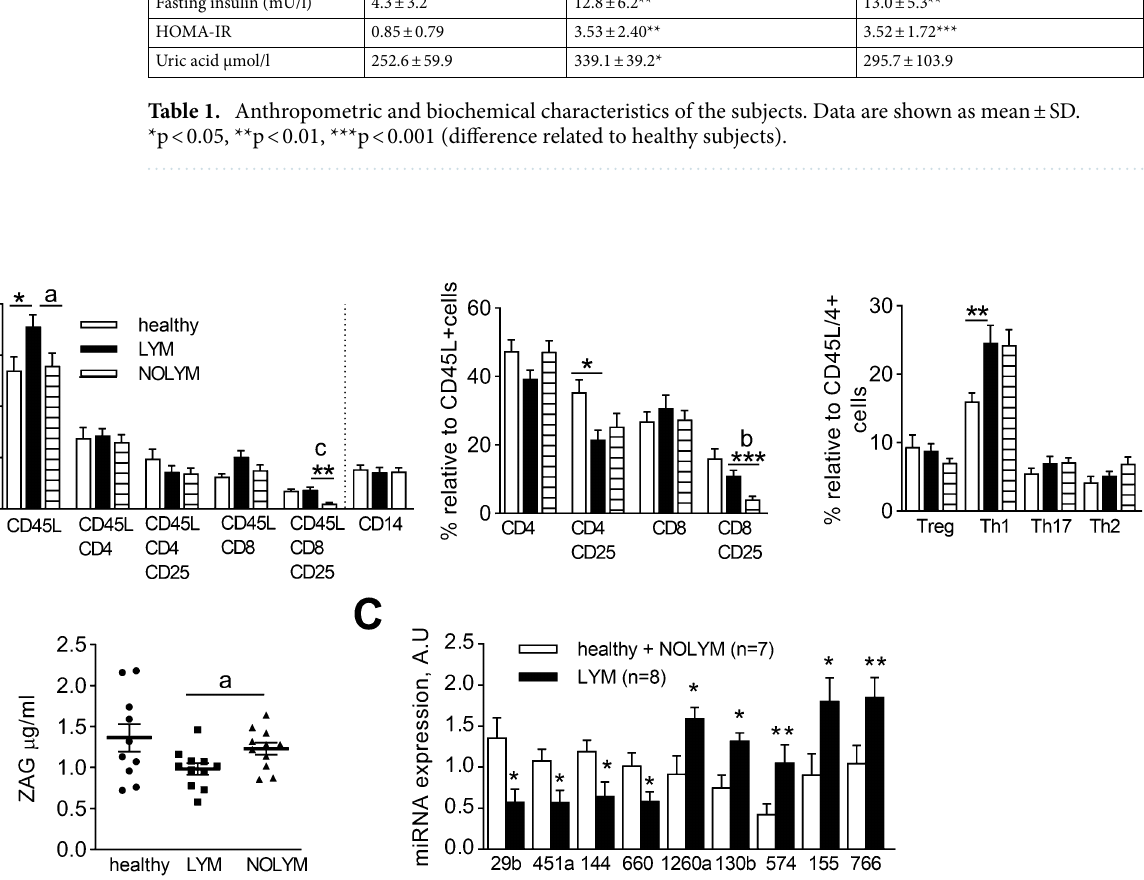
Figure 1. Systemic effects of lymphedema. ( A ) Relative content of immune cell populations in peripheral blood, expressed as percentage of CD45+ positive cells, CD45+ positive cells within lymphogate or CD45/ CD4+ positive cells within lymphogate (ANOVA of LN transformed data, Bonferroni correction for post-hoc analysis, comparison to LYM group, *p < 0.05, **p < 0.01, Mann Whitney test comparison LYM vs. NOLYM, a- p < 0.05, b- p < 0.01, c- p < 0.001). ( B ) Concentration of ZAG in plasma (Mann–Whitney test, comparison LYM vs. NOLYM, a-p < 0.05). ( C ) Levels of selected miRNA in serum. Data are presented as expression levels relative to maximal expression for each miRNA (non-parametric T-test of Log2 transformed data, *p < 0.05, **p <